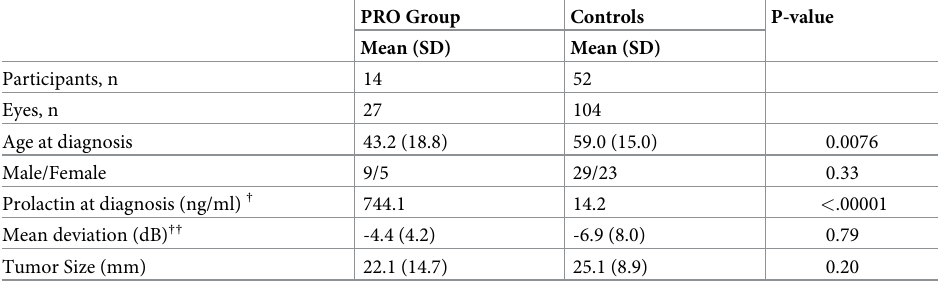
Table 1. Characteristics of the study population including mean deviation recorded by Humphrey 24–2 auto- mated perimetry. For mean deviation PRO n = 22 eyes; Controls n = 51 eyes. Welch’s T-test was used for normally distributed data, Mann-Whitney U test was performed for non-normally distributed data, and Chi-squared was used for nominal